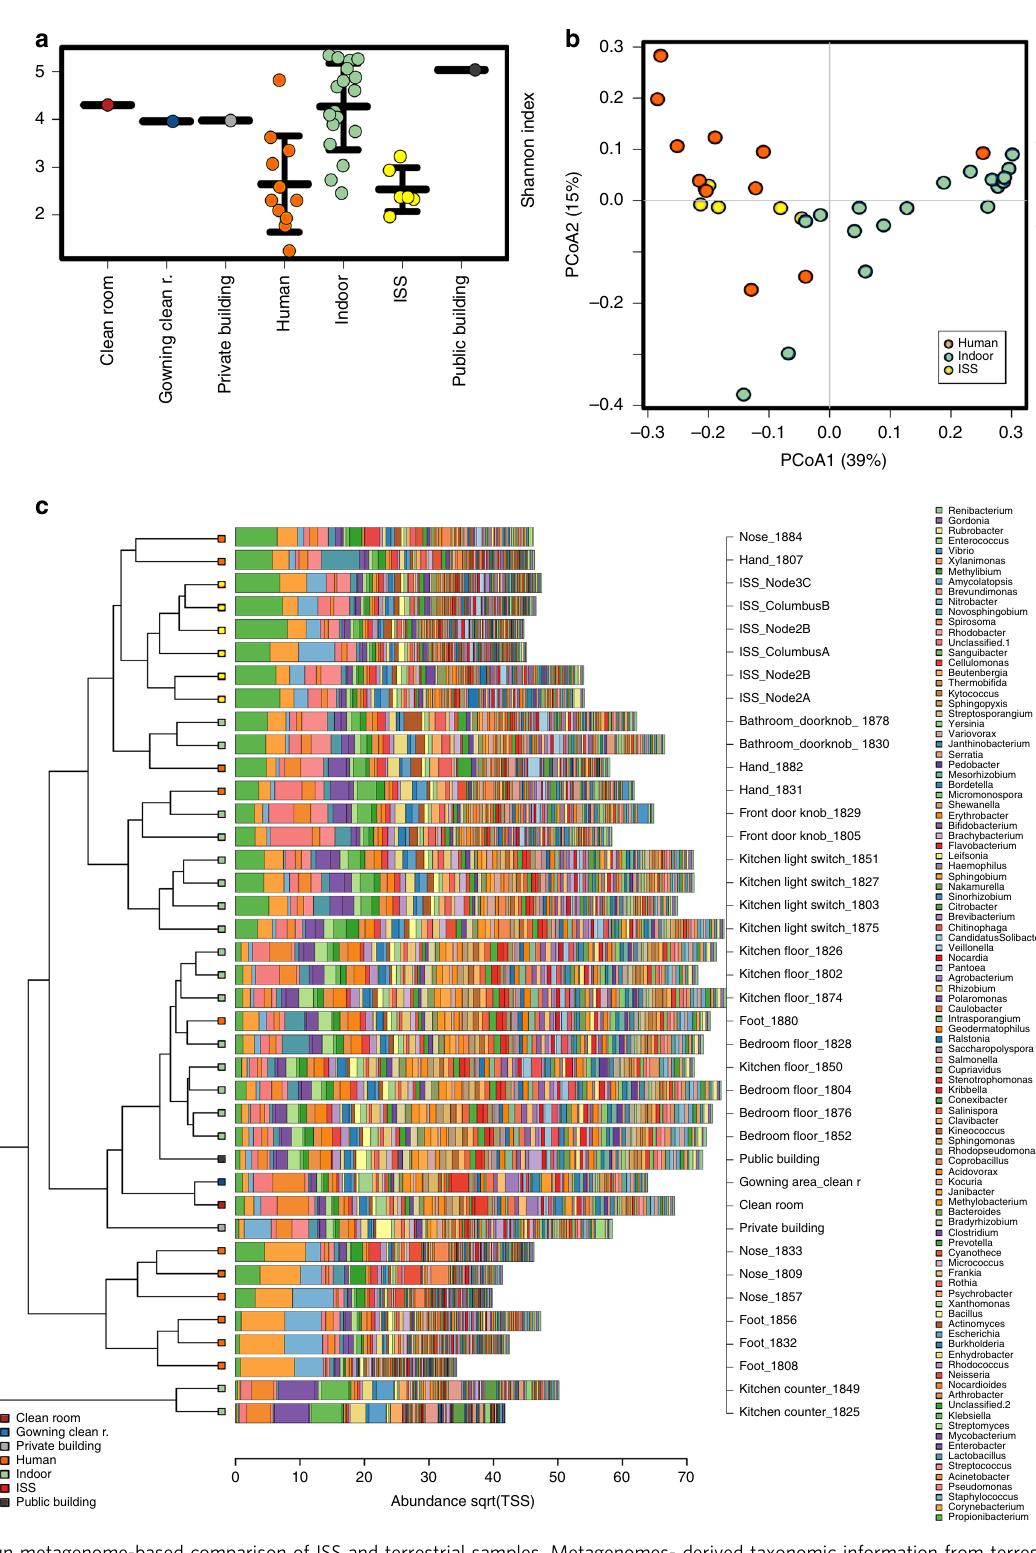
Fig. 8 Shotgun metagenome-based comparison of ISS and terrestrial samples. Metagenomes- derived taxonomic information from terrestrial indoor environments (private homes, public buildings, clean rooms), human surface samples (nose, hand, foot) and samples from the ISS (public metagenomics information taken from refs. 5,28 ). a Alpha diversity (Shannon index); error bars re fl ect standard deviation. b PCoA plot, c Clustered barchart